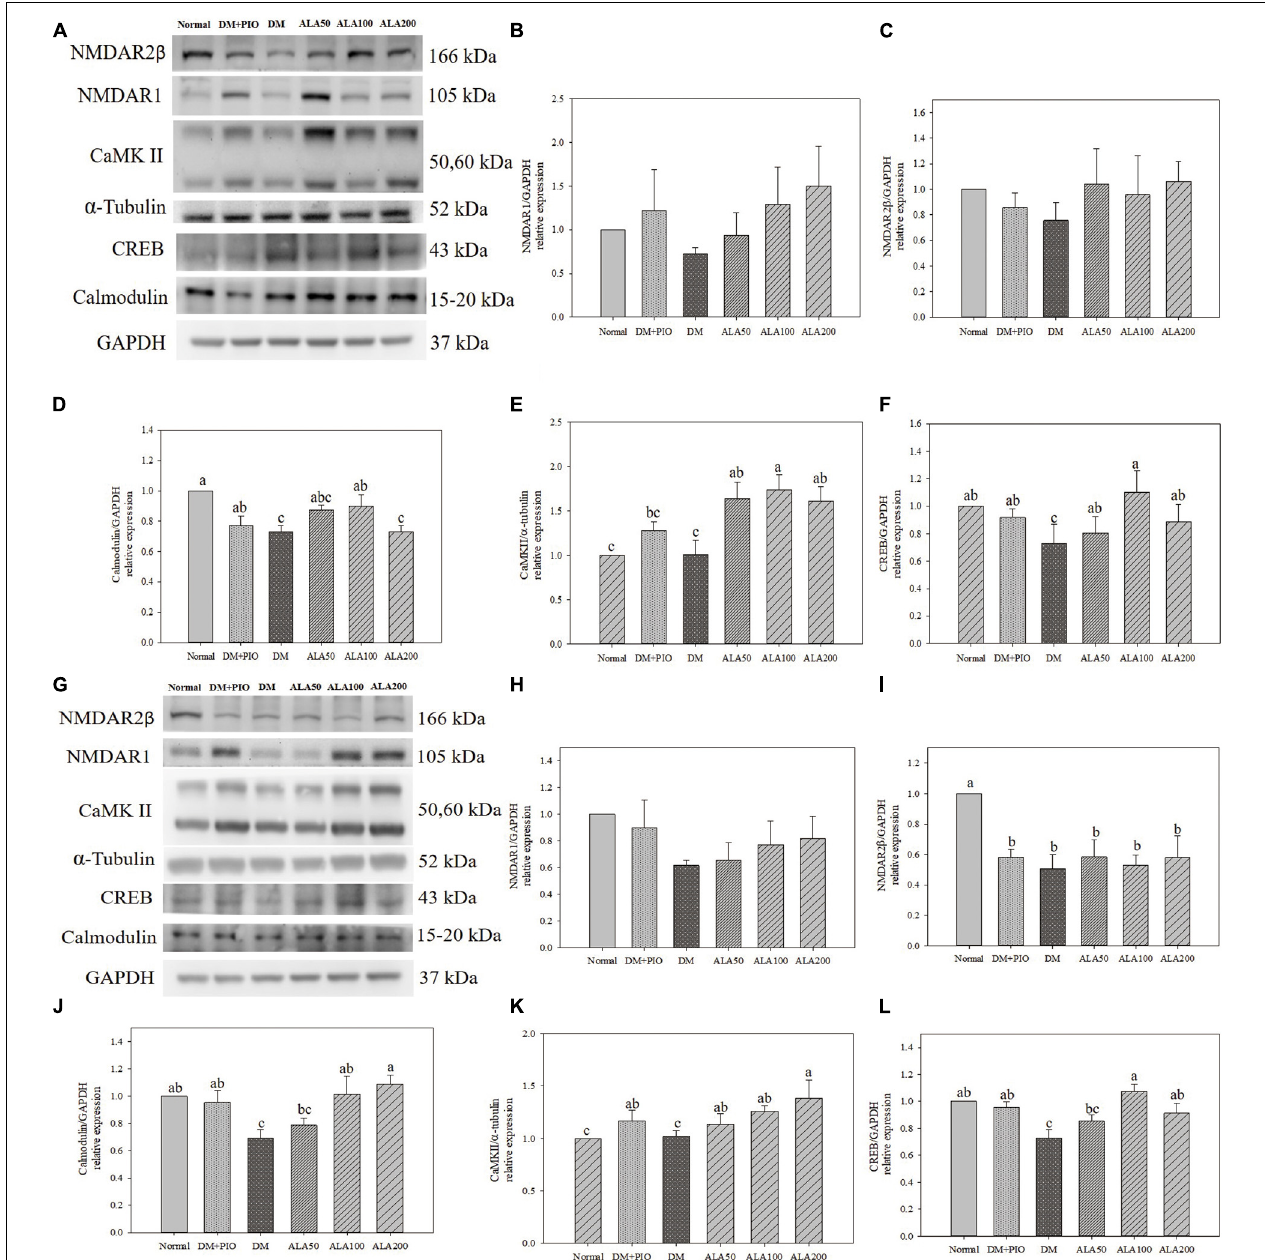
FIGURE 4 | Protein expression levels of the hippocampus (A) and cortex (G) in quantifying relative NMDAR1 (B,H) , NMDAR2 β (C,I) , calmodulin (D,J) , CaMK II (E,K) , and CREB (F,L) in high-fat diet and streptozotocin-induced type 2 diabetic rats treated with alpha-lipoic acid for 13 weeks. Normal, Normal diet; DM, high-fat diet (HFD; 60% fat) with STZ (30 mg/kg body weight, i.p.) induced diabetic rats; DM + Pio, DM rats gavaged with pioglitazone (30 mg/kg body weight) for 13 weeks; DM + ALA50, DM rats gavaged with ALA (50 mg/kg body weight) for 13 weeks; DM + ALA100, DM rats gavaged with ALA (100 mg/kg body weight) for 13 weeks; DM + ALA200, DM rats gavaged with ALA (200 mg/kg body weight) for 13 weeks. Values were calculated as the mean ± SEM, n = 6 for each group. a–c letter is significantly different among all samples tested ( p <